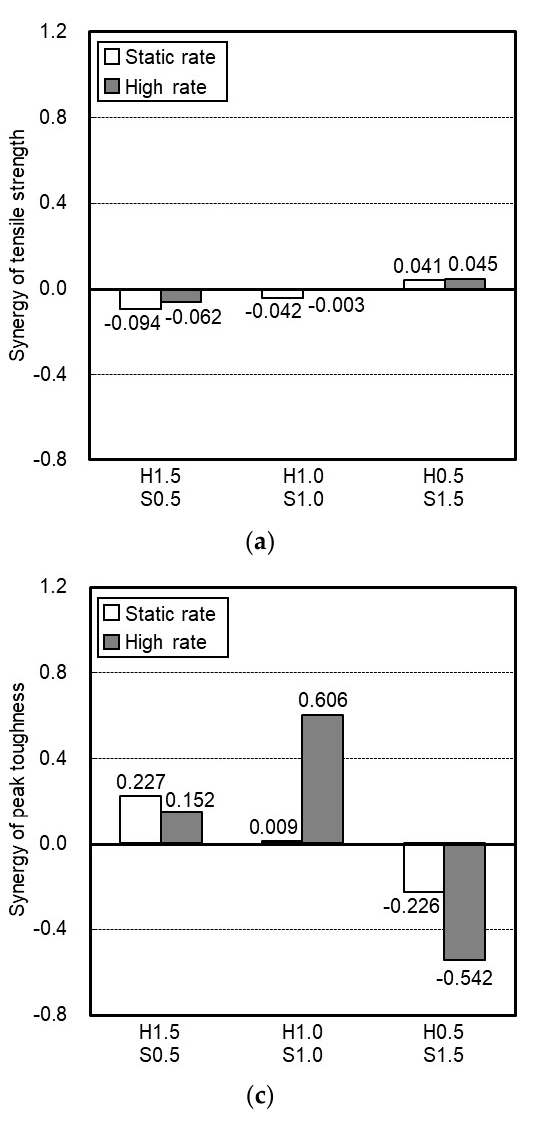
Figure 12. Synergistic effect on the tensile properties of HP-HFRCC: ( a ) tensile strength; ( b ) strain capacity; ( c ) peak toughness; ( d ) softening toughness.